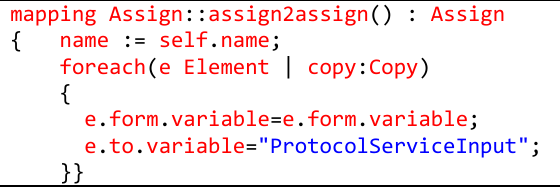
Fig. 11. Transformation Rule for Modifying Assign Activity